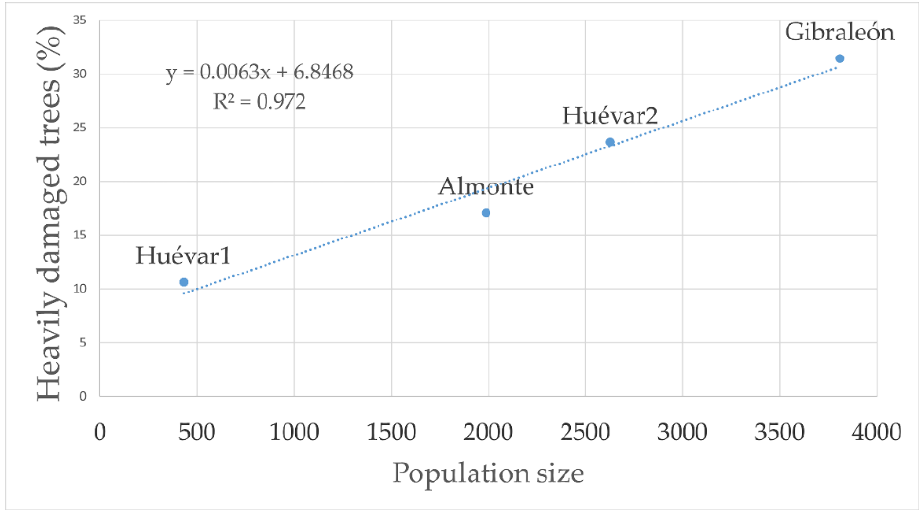
Figure 6. Linear relationship between wood borer population size and degree of severe damage to trees.